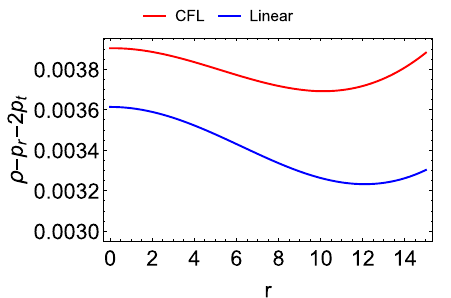
Fig. 9 Variation of weak energy condition as a function of the radial coordinate